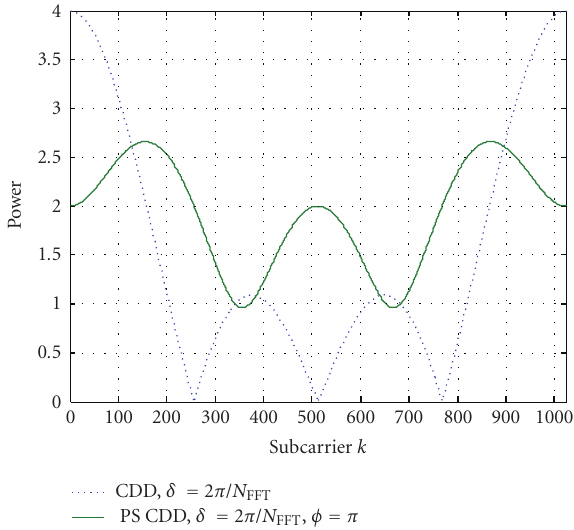
Figure 1: Comparison of powers of composite channels with CDD and PS